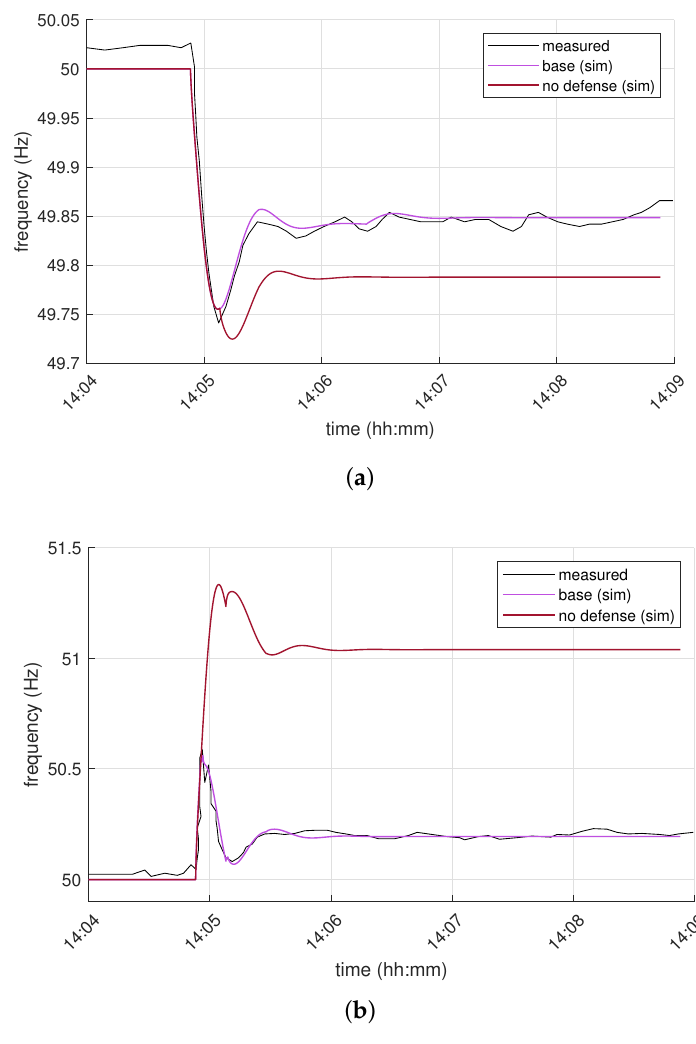
Figure 12. Comparison of simulation results for variant scenario of no defensive actions: ( a ) frequency in North-West part; ( b ) frequency in South-East